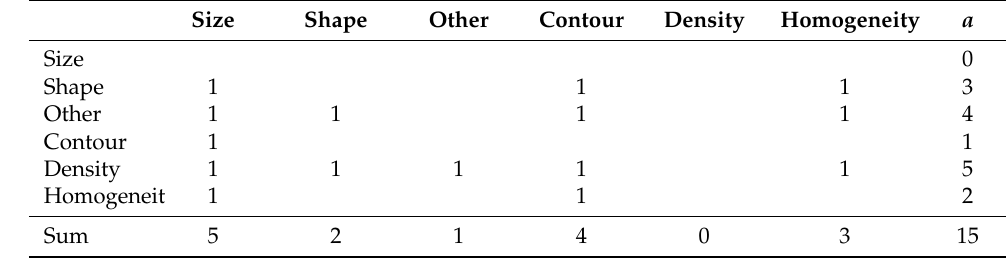
Table 2. The preference table of Expert 2 is used as an example. The number of attributes is n = 6. The first column, as well as the first row, shows the attributes, the 6 × 6 matrix shows 1 for those cases when the attribute in the row is preferred to the attribute in the column (the diagonal is of course empty). Column a is the number of cases when the given attribute is preferred (this is shown in the figures later in Section